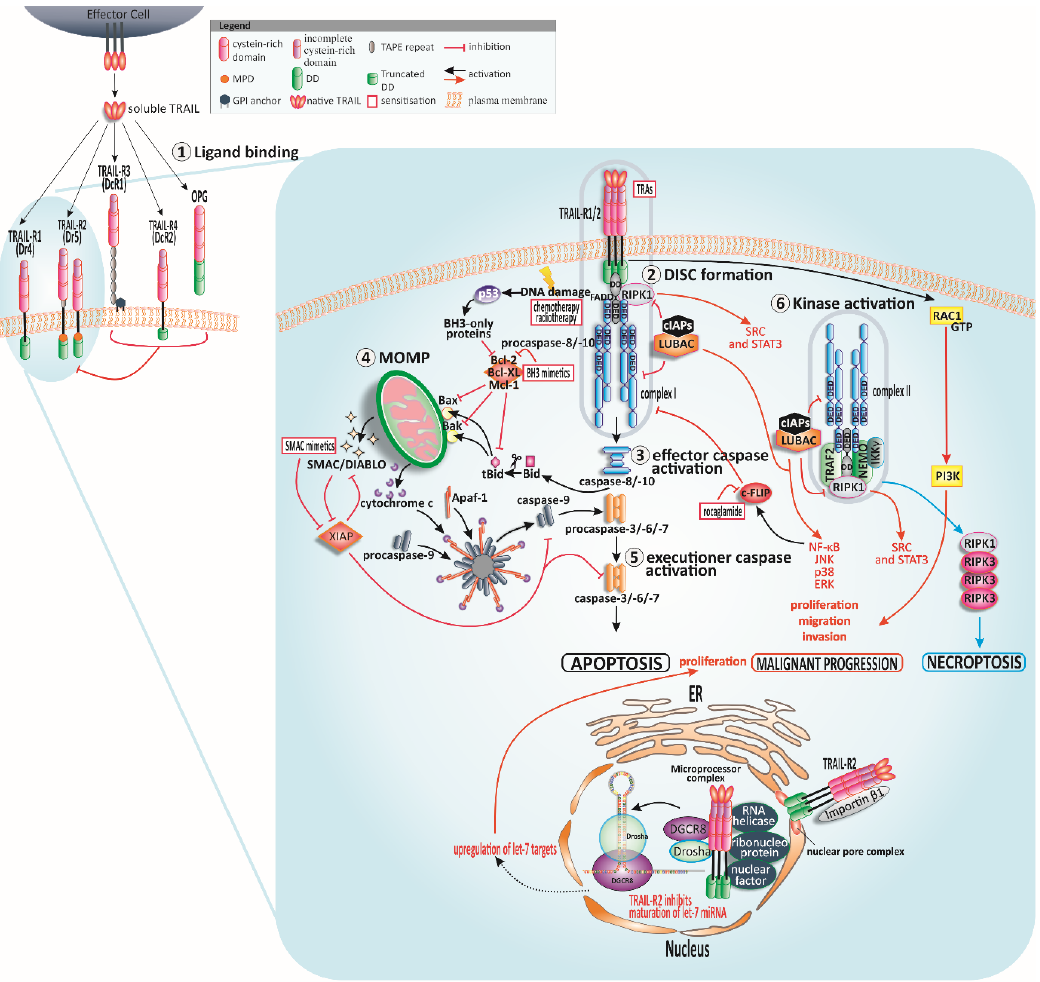
Figure 1. TRAIL signalling and sensitisation. Human tumour-necrosis-factor-related apoptosis-inducing TRAIL signalling and ligand (TRAIL) can bind to four membrane-bound TRAIL receptors (TRAIL-Rs) and one soluble receptor ① . TRAIL-R1 and TRAIL-R2 can trigger apoptotic signals while the other receptors might serve as